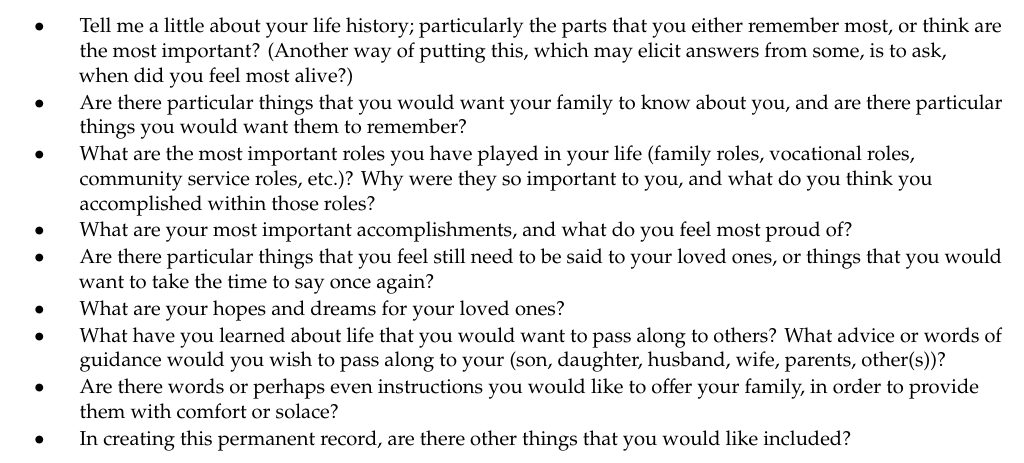
Table 2. Framework of questions used in Dignity Therapy (DT) modified for the elderly